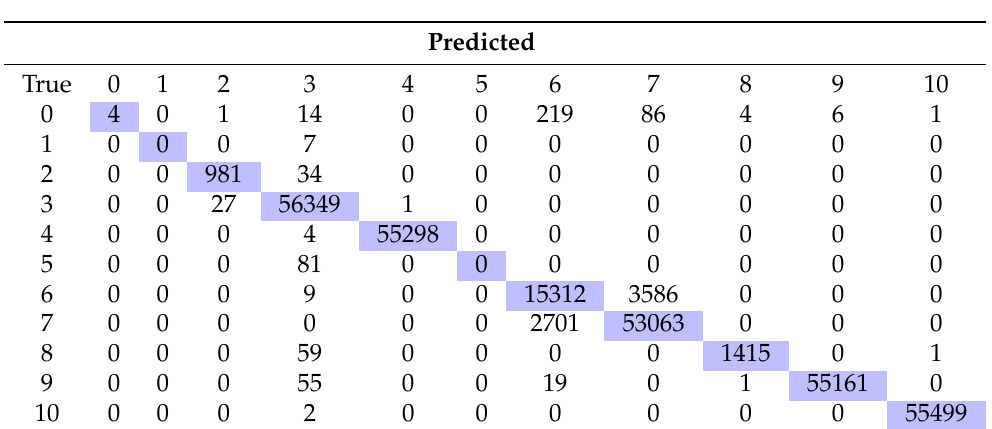
Table 50. ANN confusion matrix.